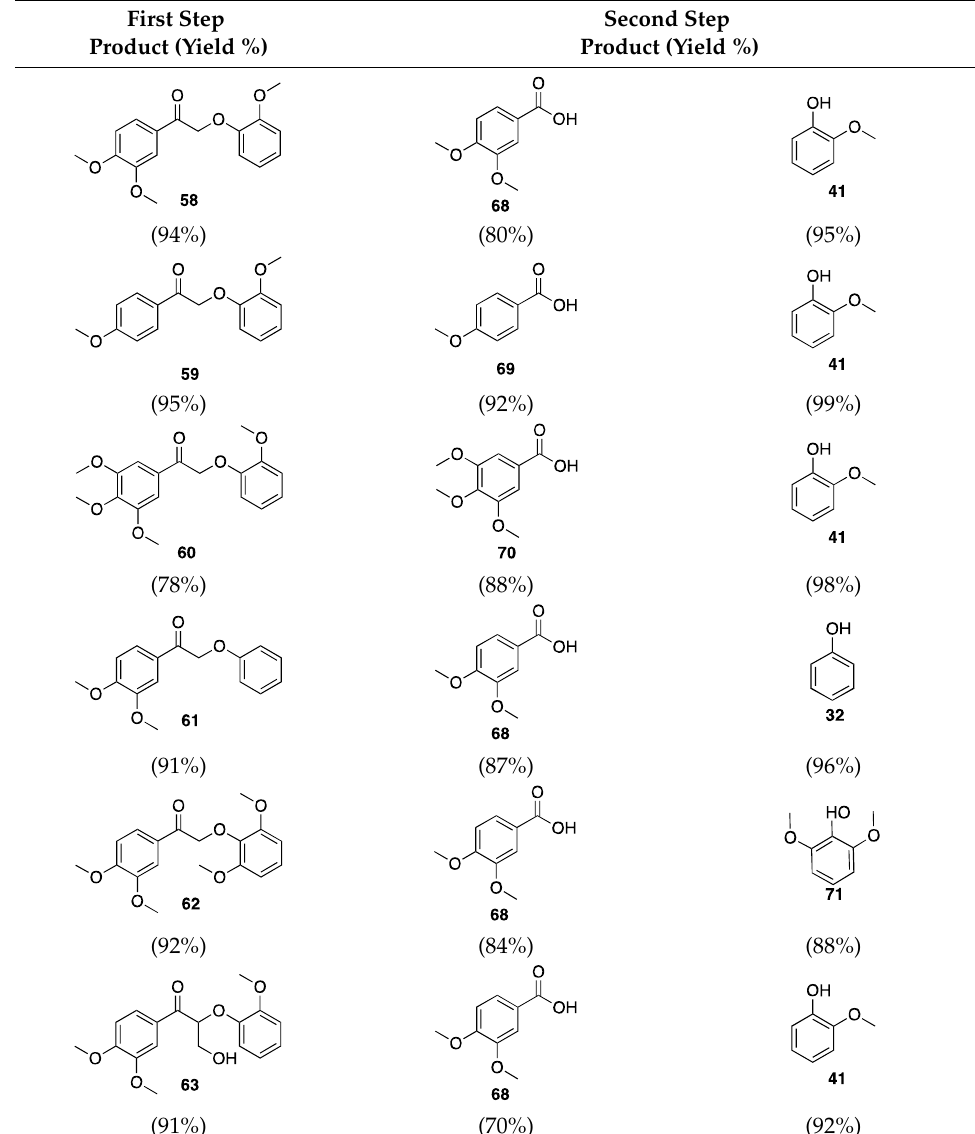
Table 2. Substrate scope.